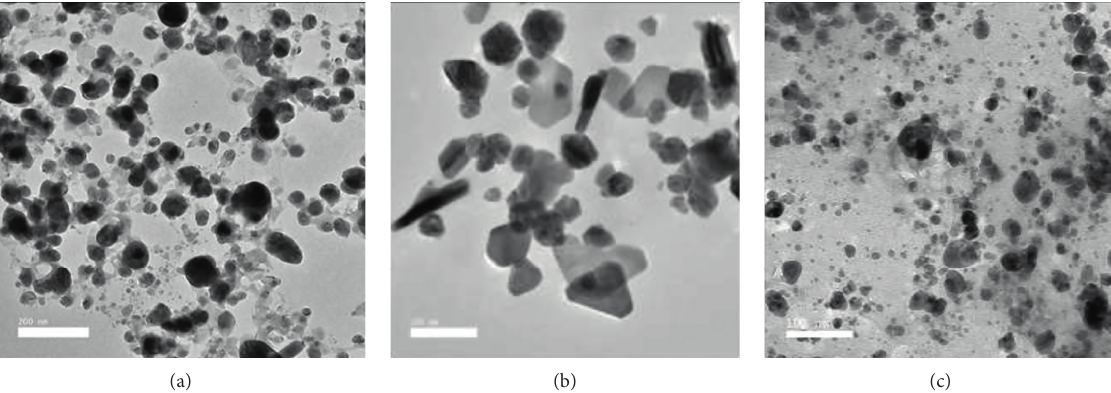
Figure 4: TEM image of silver nanoparticles synthesised using (a) lemon peel, (b) orange peel, and (c) green orange peel extract.